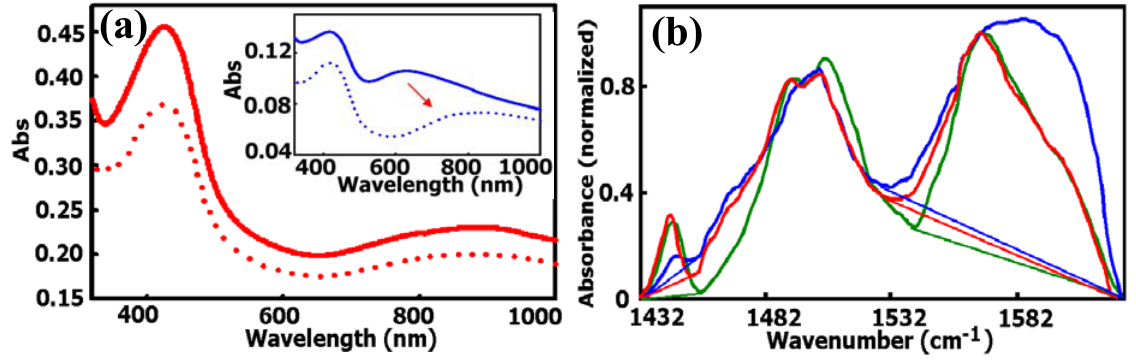
Figure 3. (a) UV-vis spectra of the PABA/ss-DNA/SWNT composite (red) and the pure PABA (inset, blue) before (-) and after (···) treatment with NaBH composite (red) and the pure PABA (blue) and the pure PABA after reduction with NaBH (green). The spectra were normalized with the 1570 cm -1 peak. Baselines for the absorption height ratio measurements are shown. (Reproduced with permission from the American Chemical Society